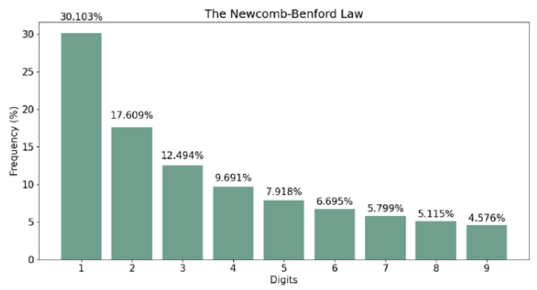
Figure 1. The Newcomb–Benford Law.